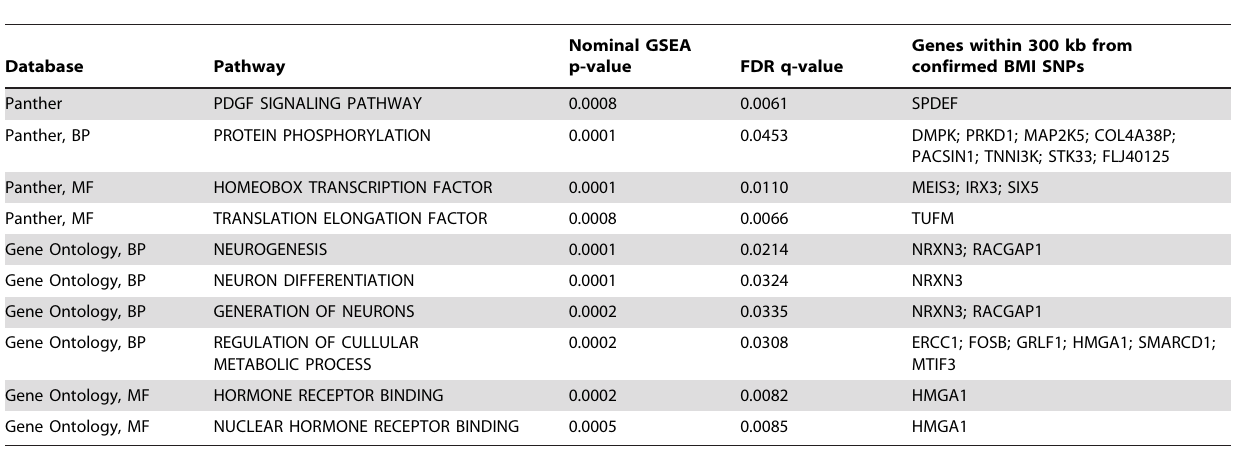
Table 1. Pathways with significant enrichment for associations of the top 25% of SNP associations detected by GIANT